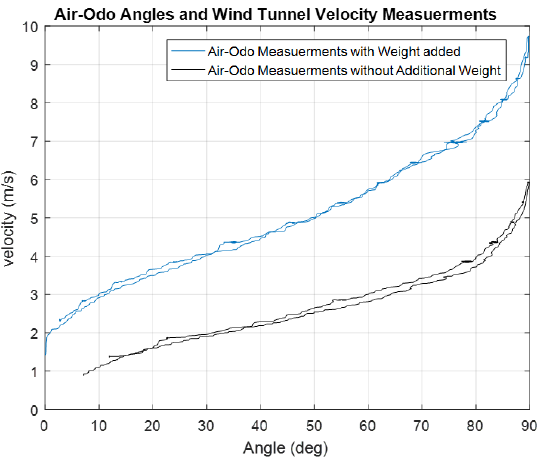
Figure 4. Air-Odo angle measurements and Wind-tunnel velocities relationship.